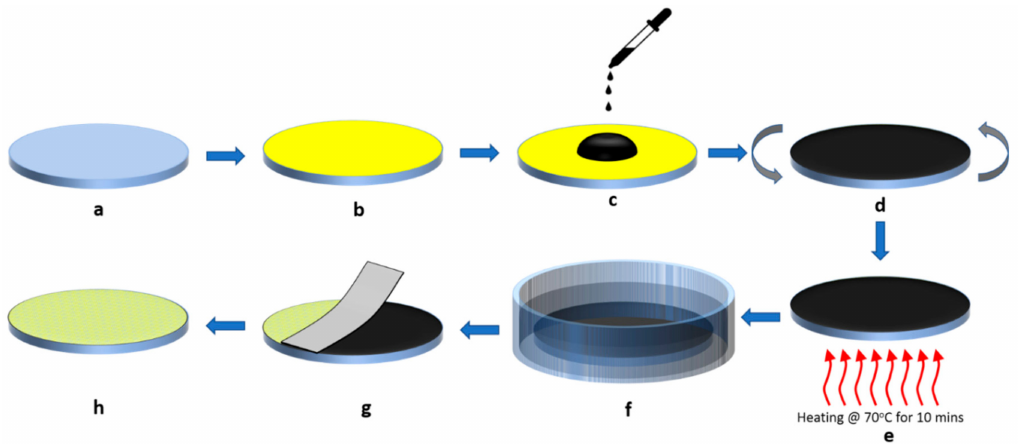
Figure 1. Schematic illustration of the fabrication process for porous gold thin film: ( a ) cleaning the Cyclic Olefin Copolymer (COC) wafer; ( b ) deposition of gold film on the wafer; ( c ) dispersion of the graphene oxide (GO) layer on top of the gold film; ( d ) spinning the wafer for 30 s; ( e ) heating the wafer at 70 ◦ C for 10 minutes; ( f ) etching the gold film; ( g ) stripping-o ff the GO layer using an adhesive tape; ( h ) illustration of the porous gold thin film on top of the COC